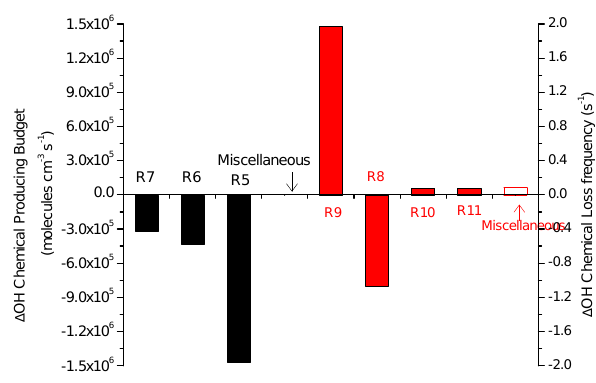
Fig. 9. Differences of the daily average chemical produc- tion budgets (black bars) and chemical loss frequencies (red bars) of OH, between the DUST J and NO DUST simulations (DUST J − NO DUST) in the T04 case. “Miscellaneous” (hollow bars) represents the sum of all the other source or loss terms. The reactions are listed in Table